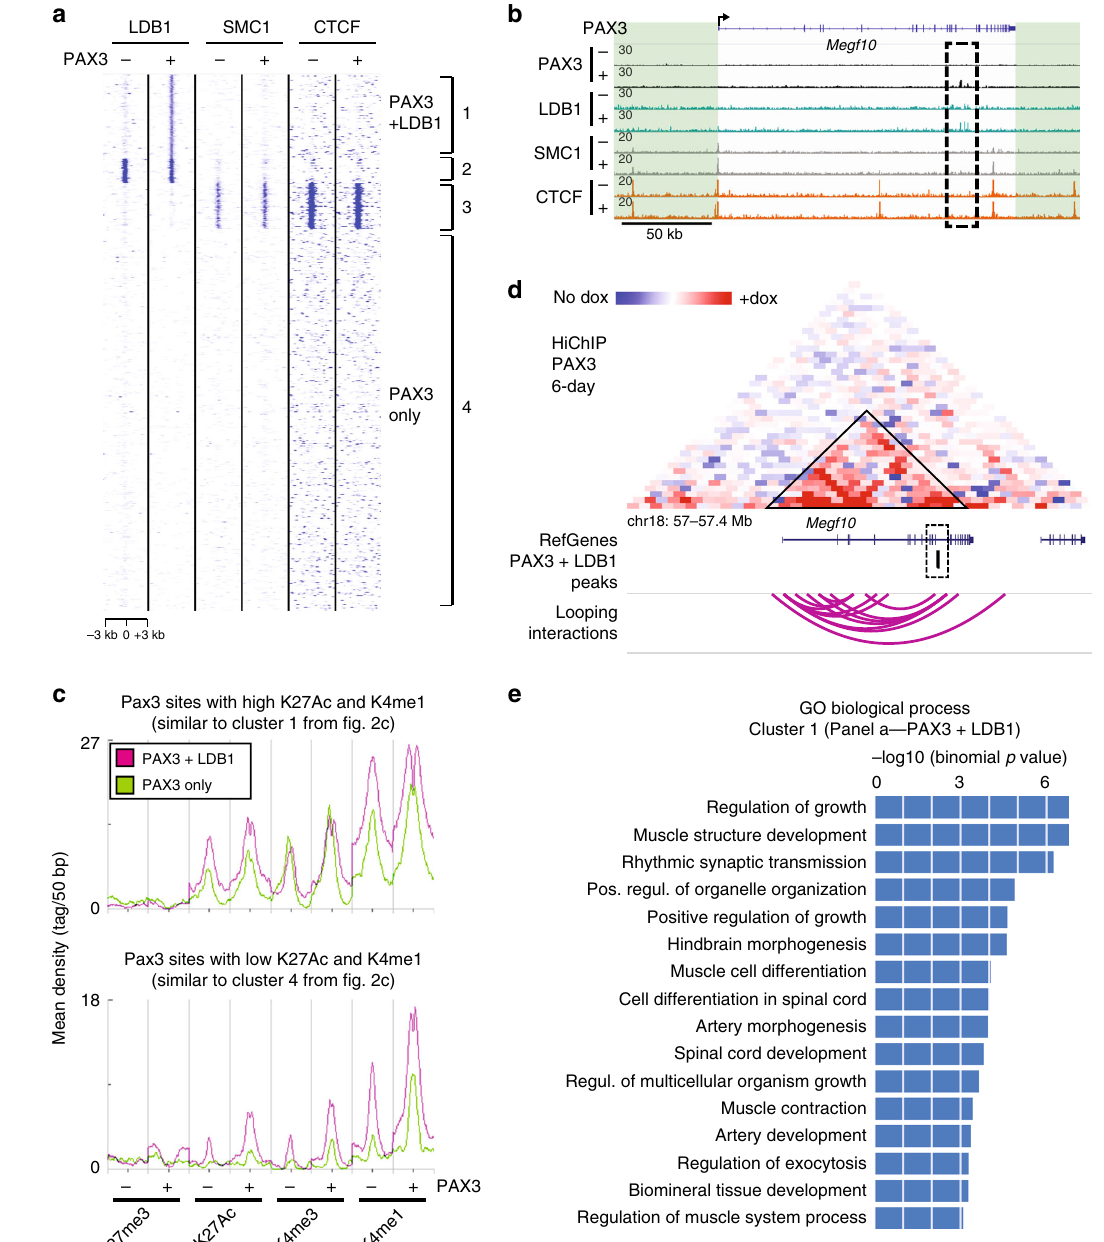
Fig. 4 Ldb1 recruitment at Pax3 sites is associated with enhanced chromatin remodeling and looping. a k-means clustering of ChIP-seq data for LDB1, SMC1, and CTCF in 1-day Pax3-induced ( + ) and non-induced ( − ) EBs. Density Tag Map centered on 3780 PAX3 peaks shows the recruitment of LDB1 upon Pax3 induction at a subset of loci (cluster 1), and reveals that PAX3-mediated LDB1 recruitment is independent from SMC1-CTCF complex. Cluster 1: 595 peaks; Cluster 2: 168 peaks; Cluster 3: 324 peaks; Cluster 4: 2693 peaks. b IGV track displaying PAX3, LDB1, SMC1, and CTCF genome occupancy at the Megf10 locus in 1-day Pax3-induced ( + ) and non-induced ( − ) EBs. Dashed black square indicate PAX3-mediated LDB1 recruitment. Green boxes represent intergenic regions. Black arrow represents the transcription start site. c Graph shows distribution of ChIP-seq reads for the selected marks at loci characterized by PAX3 + LDB1 recruitment (violet) and PAX3-only binding (green). Loci bound by both LDB1 and PAX3 display higher remodeling compared with PAX3-only bound sites. d HiChIP normalized matrix from 6-day Pax3-induced cells displaying the Megf10 locus demonstrates long-range interactions involving the 1-day bound PAX3 + LDB1 site (dashed black square from panel b ). Position of PAX3 peaks, genes and chromosome coordinates are showed below the matrix. Scale: maxrange = 0.2. Arcs indicate looping interactions identi fi ed by FitHiChIP. e GREAT functional annotation of peaks characterized by PAX3-mediated LDB1 recruitment (cluster from Fig.